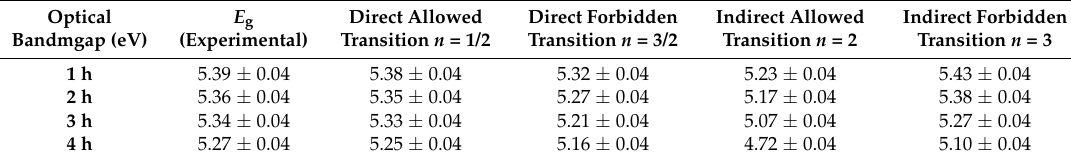
Figure 11. Extraction of: ( a ) the experimental optical band gap using extinction coefficient and ( b ) optical band gap from Mott and Davis Model for n = 1/2 transition. Table 5. Variation of band gap energy for willemite NPs calcined at 900 ◦ C for different calcination holding